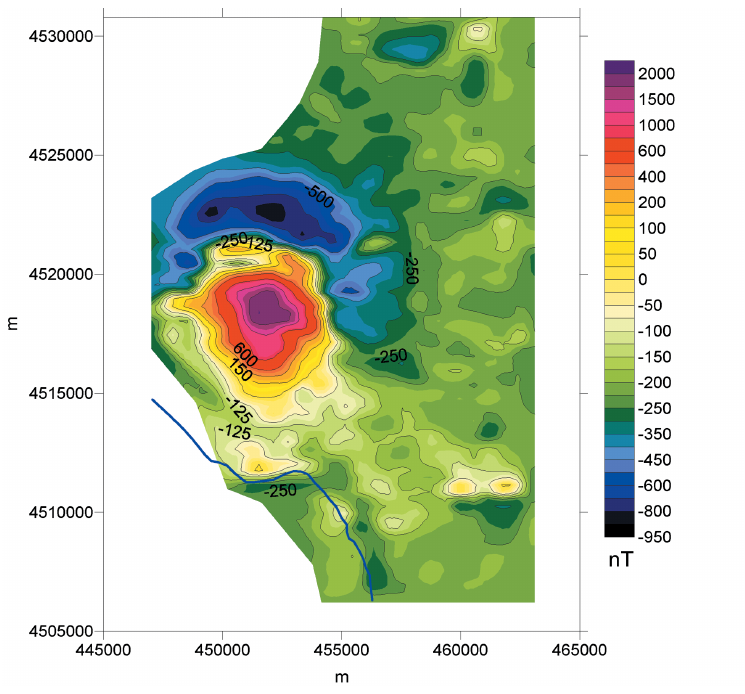
Fig. 5. High frequency filtered map of the new magnetic data set of the Vesuvian area. Coastline in